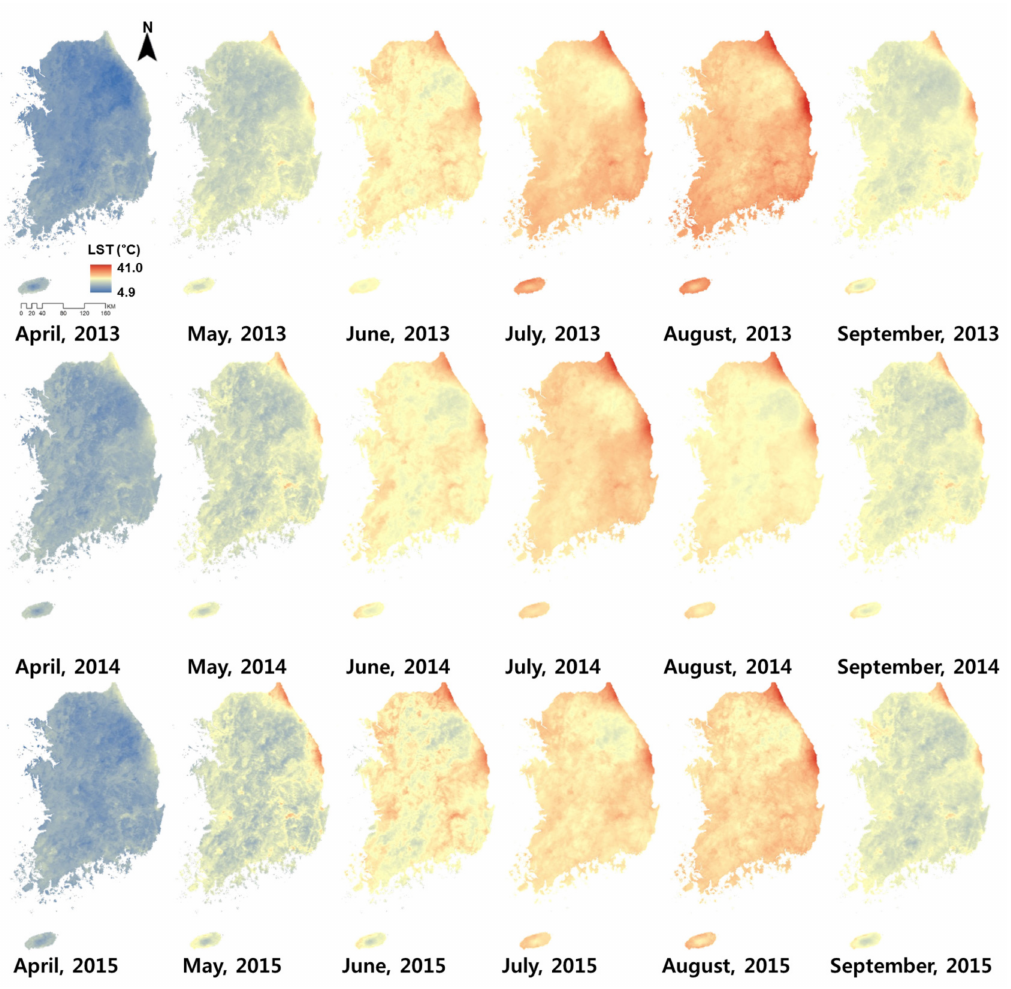
Figure 7. Final monthly spatial distribution maps of LST during drought